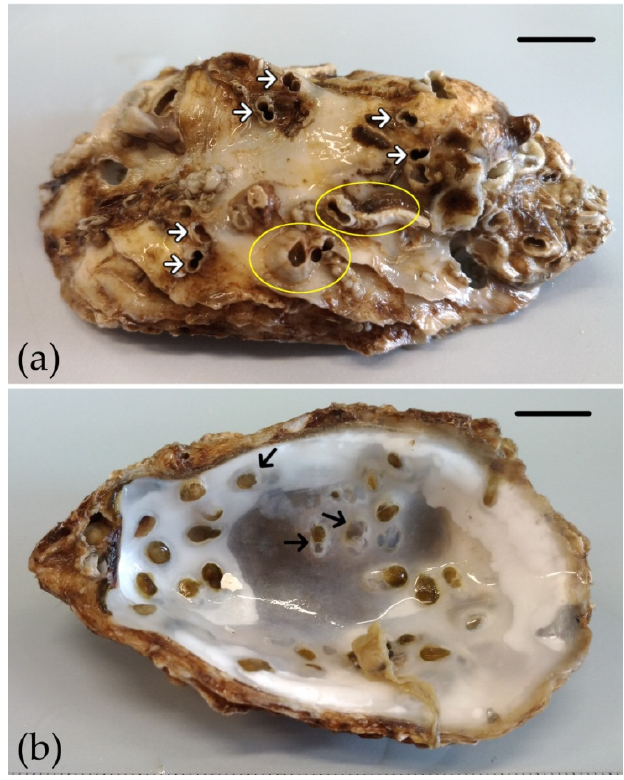
Figure 2. Upper valve of the oyster Magallana gigas infested by Rocellaria dubia (the most infested oyster from research): ( a ) external view: white arrows indicate “8”-shaped siphon openings of Rocellaria dubia , yellow circles indicate siphons penetrating through barnacle and polychaete tube; ( b ) internal view: black arrows indicate holes made by Rocellaria dubia , covered by the callus produced by the oyster. Scale bars—10 mm.